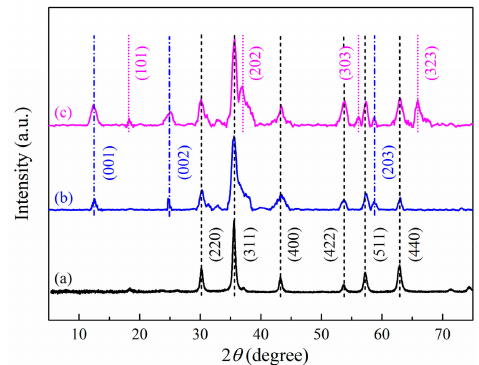
Figure 3. XRD patterns of hollow Fe 3 O 4 microspheres ( a ), hollow flower-like Fe 3 O 4 / MnO 2 microspheres ( b ), and hollow flower-like Fe 3 O 4 / MnO 2 / Mn 3 O 4 photocatalyst ( c